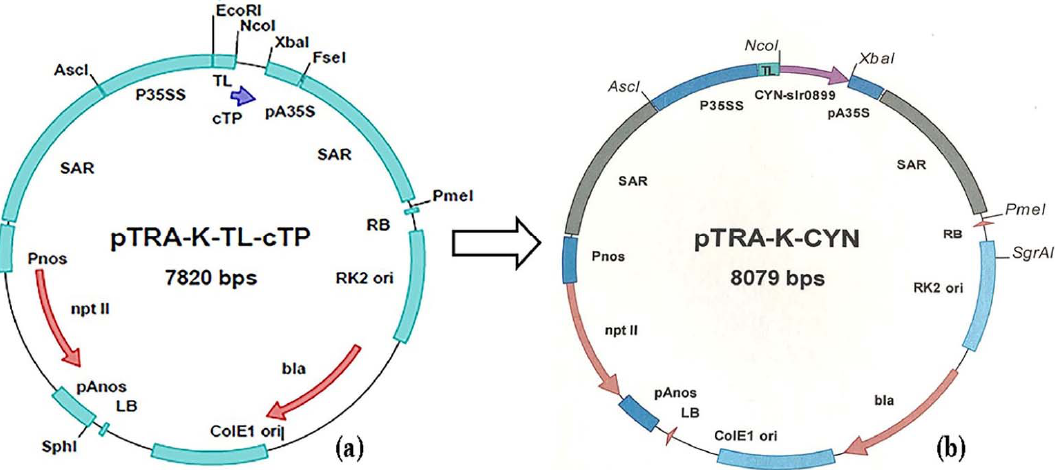
Figure 1. ( a ) Structure of pTRA-K-TL-cTP binary expression vector. ( b ) Structure of pTRA-K-CYN plasmid DNA. Synechococcus elongatus PCC 6803 cyanase gene was cloned into the binary plant expression vector, pTRA-K (gi13508478), between NcoI and XbaI sites. CYN gene cassette is flanked by scaffold attachment regions (SAR) of the tobacco RB7 gene tobacco leader peptide (TL), and 3 ′ UTR of CaMV 35S (pA35S). LB/RB: left and right border sequences of nopaline-Ti-plasmids pTiT37. pAnos: polyadenylation signal of nopaline synthetase gene from A. tumefaciens . NptII: neomycin phosphotransferase type II refers to resistance to kanamycin. pnos: promoter of nopaline synthase gene from A. tumefaciens